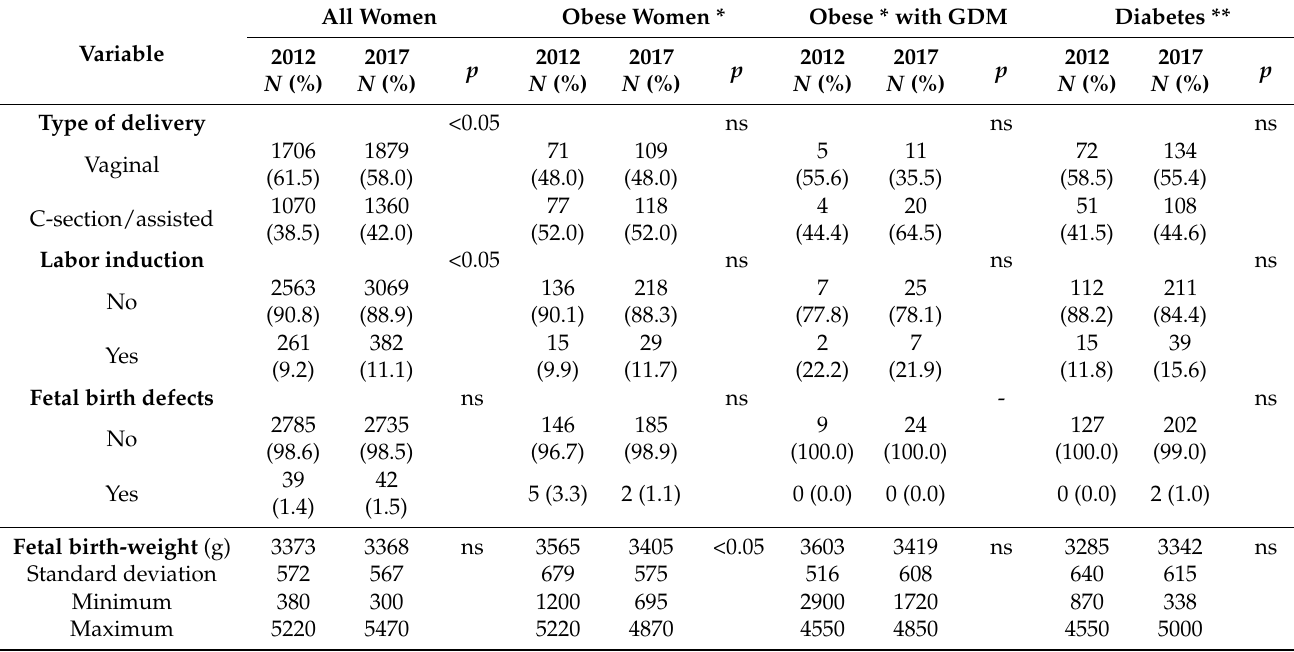
Table 3. Selected perinatal outcomes in the individual groups of women analysed in years 2012 and